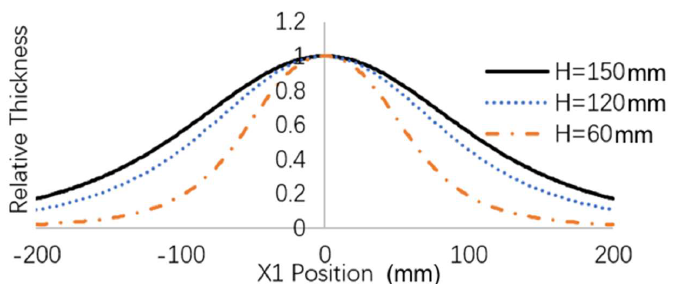
Figure 16. Relative film thickness distribution at X 1 positions, as described in Figure 14.